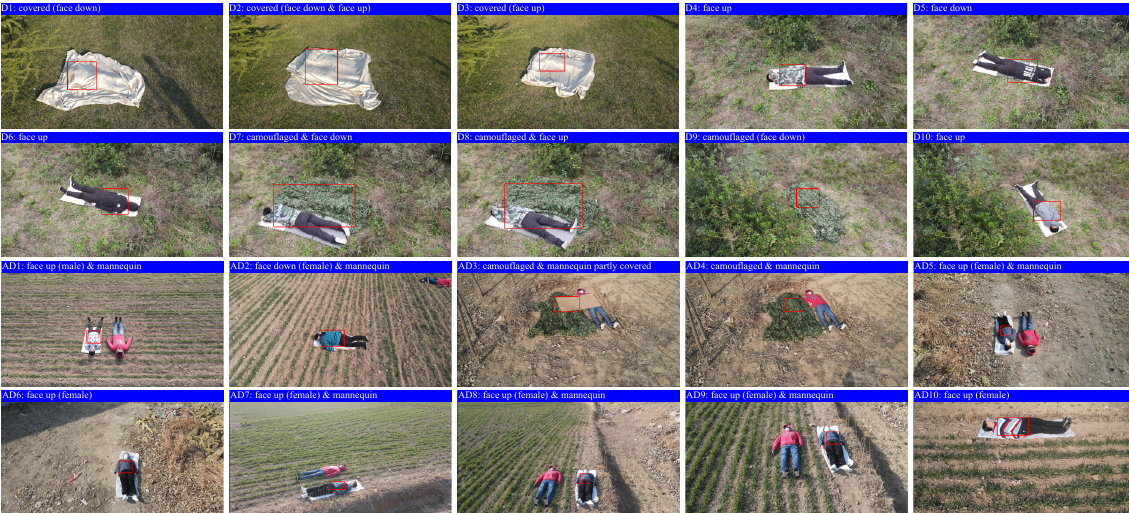
Figure 2. The first frames and ground truth regions indicated with red boxes for 20 drone videos. The name and the simulated scenario of each drone video are shown on the top of every frame